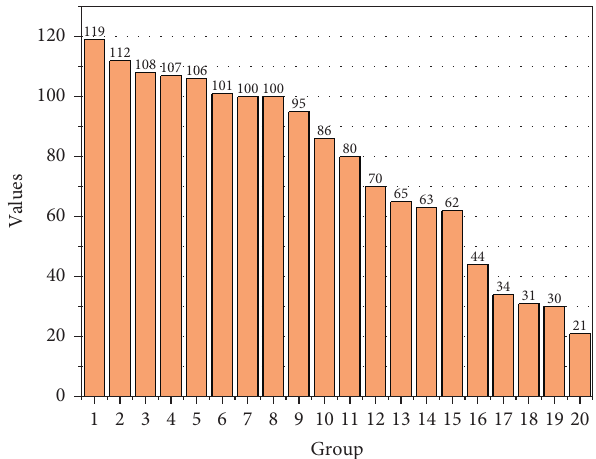
Figure 4: Group industry benchmarking ranking.